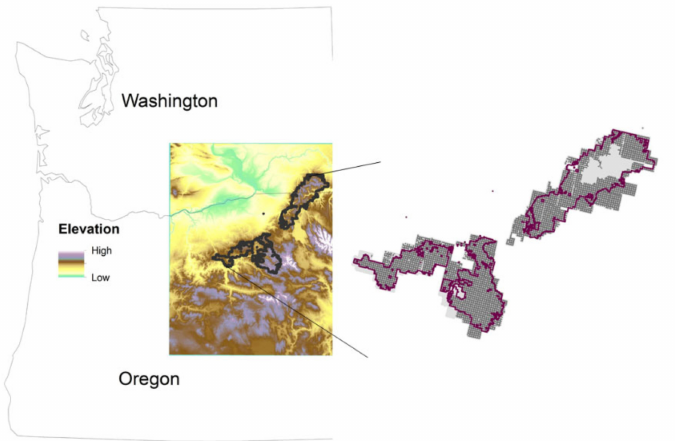
Figure 1. Area of General Land O ffi ce (GLO) surveys (gray) in the Umatilla National Forest, with the north unit in eastern Oregon and Washington and south units in eastern Oregon. Lighter gray indicates where soil surveys are